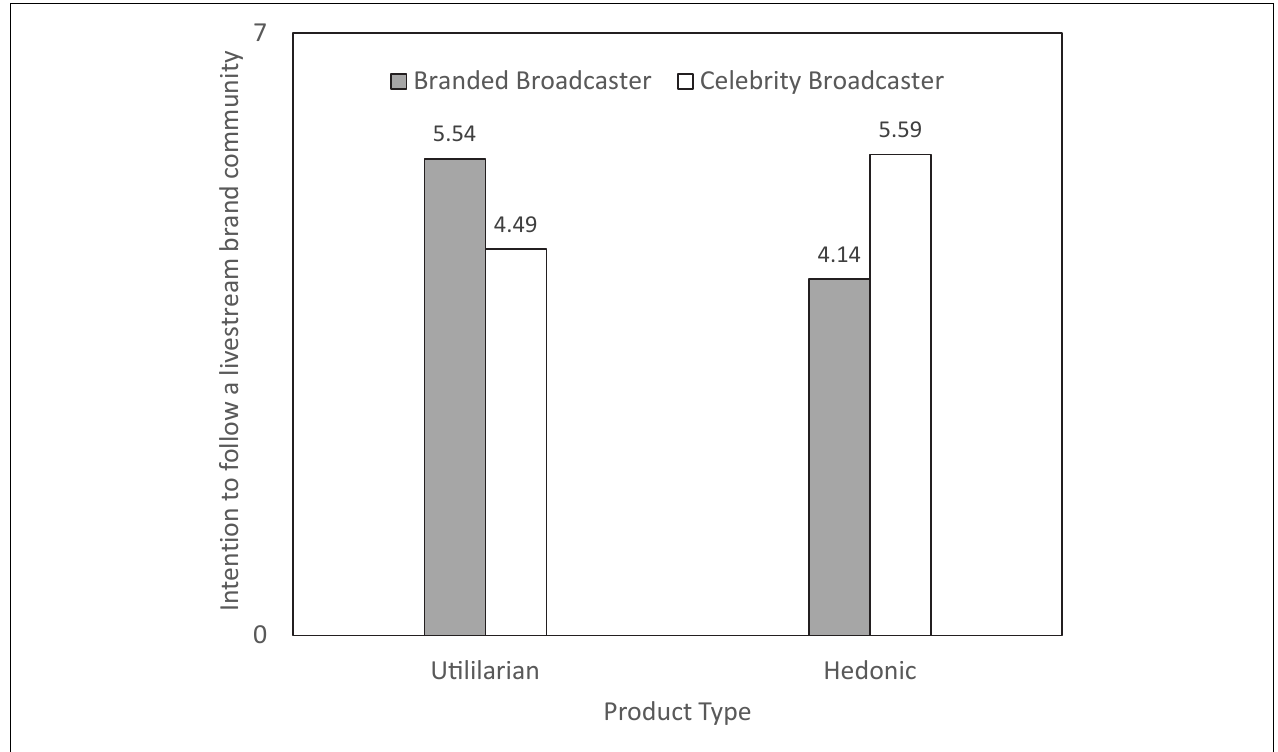
FIGURE 2 | Study 2: Interaction of broadcaster type and product type on consumer’s intention to follow a livestream brand community.